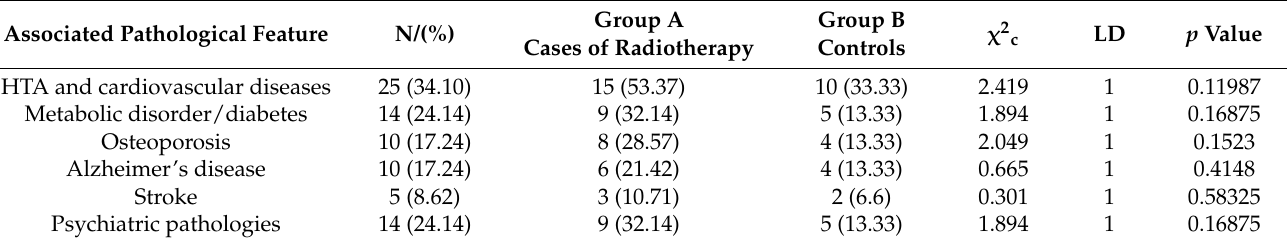
Table 2. The associative pathological features of the study groups.